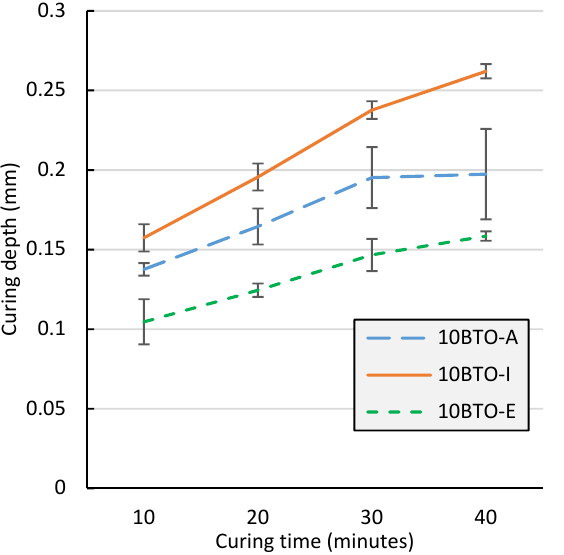
9 of 24 Figure 3. Viscosity values of 10 vol.% BTO/photopolymer suspensions dispersed with different solvents. Figure 4 shows the curing depths of the 10 vol.% BTO/photopolymer suspensions. The suspension dispersed in isopropyl alcohol shows the highest curing depth, while eth-